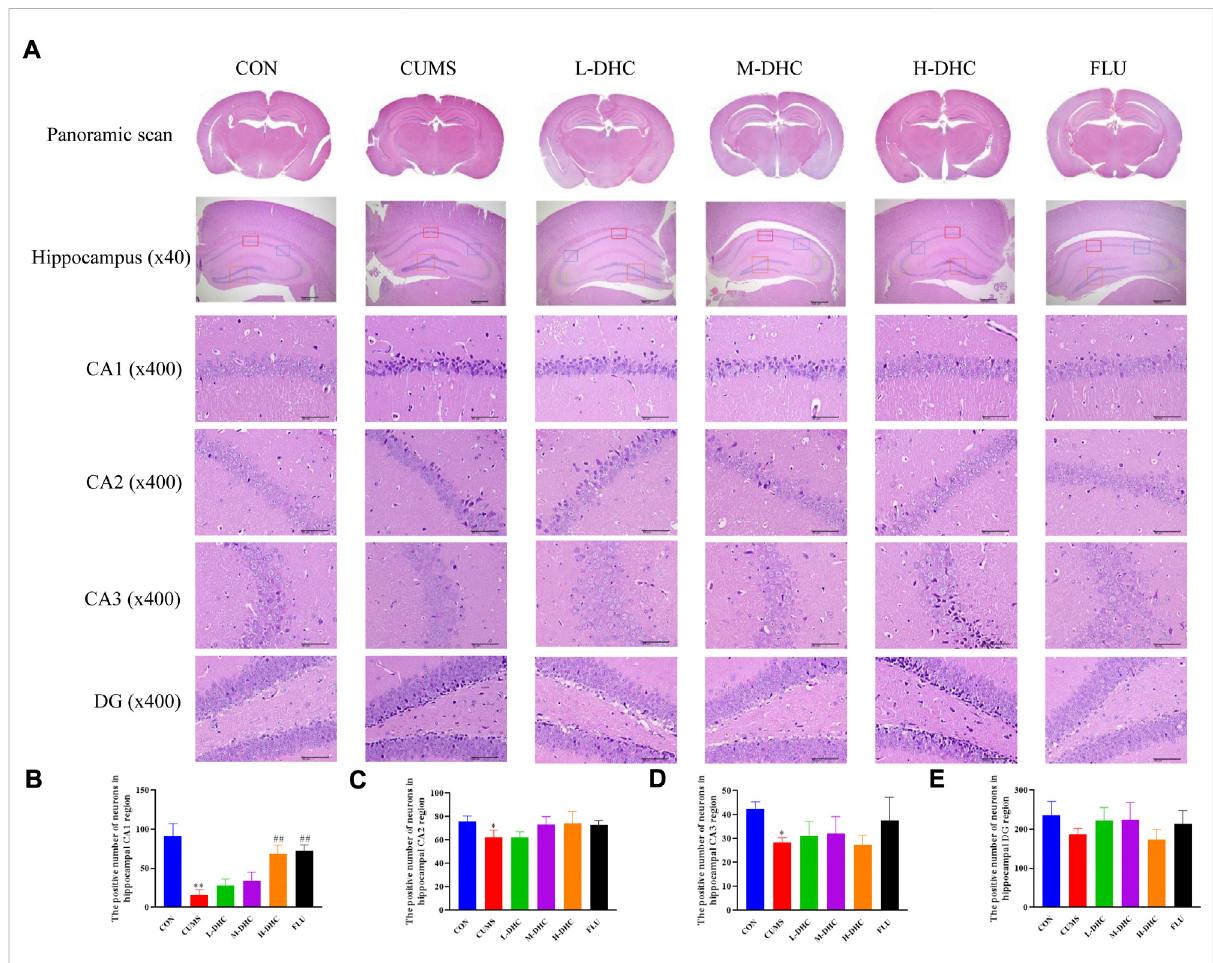
FIGURE 2 EffectsofDHCor fl uoxetineonthemorphologicalchangesofthehippocampalregioninCUMS-induceddepressioninmice. (A) Representative images of hematoxylin-eosin (H&E) staining in thehippocampalregion ofbrain tissue. Previously mentioned is apanoramicscanof brain tissue after H&E staining; the following image is a HE staining of the CA1, CA2, CA3, and DG regions of the hippocampus, ×400 magni fi cation (scale bar 50 μ m). The red box represents the CA1 region, the blue box represents the CA2 region, the green box represents the CA3 region, and the orange represents the DG region; (B) the positive number of neurons in the hippocampal CA1 region of mice in each group; (C) the positive number of neurons in the hippocampal CA2 region of mice in each group; (D) the positive number of neurons in the hippocampal CA3 region of mice in each group; and (E) the positive number of neurons in the hippocampal DG region of mice in each group. * p < 0.05 and ** p < 0.01, compared with the control (CON) group; ## p < 0.01, compared with the CUMS